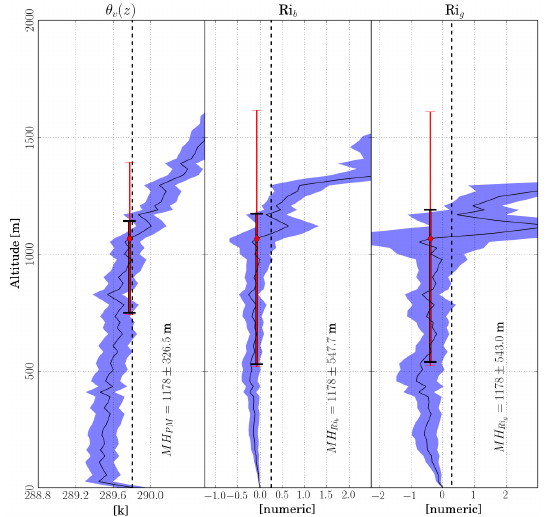
Figure 12. Potential temperature, Ri b and Ri g profiles at the Lin- denberg Meteorological Observatory on 6 June 2010, 18:00UTC. The propagated errors are depicted as light blue areas around the is depicted as a red profiles. On each plot, the localization error σ x m error bar. Black bars represent the distinct contributions e 1 and e 2 to σ x m